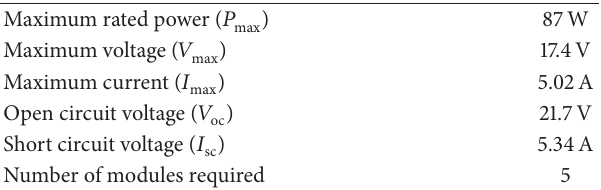
Table 4: Parameters of PV